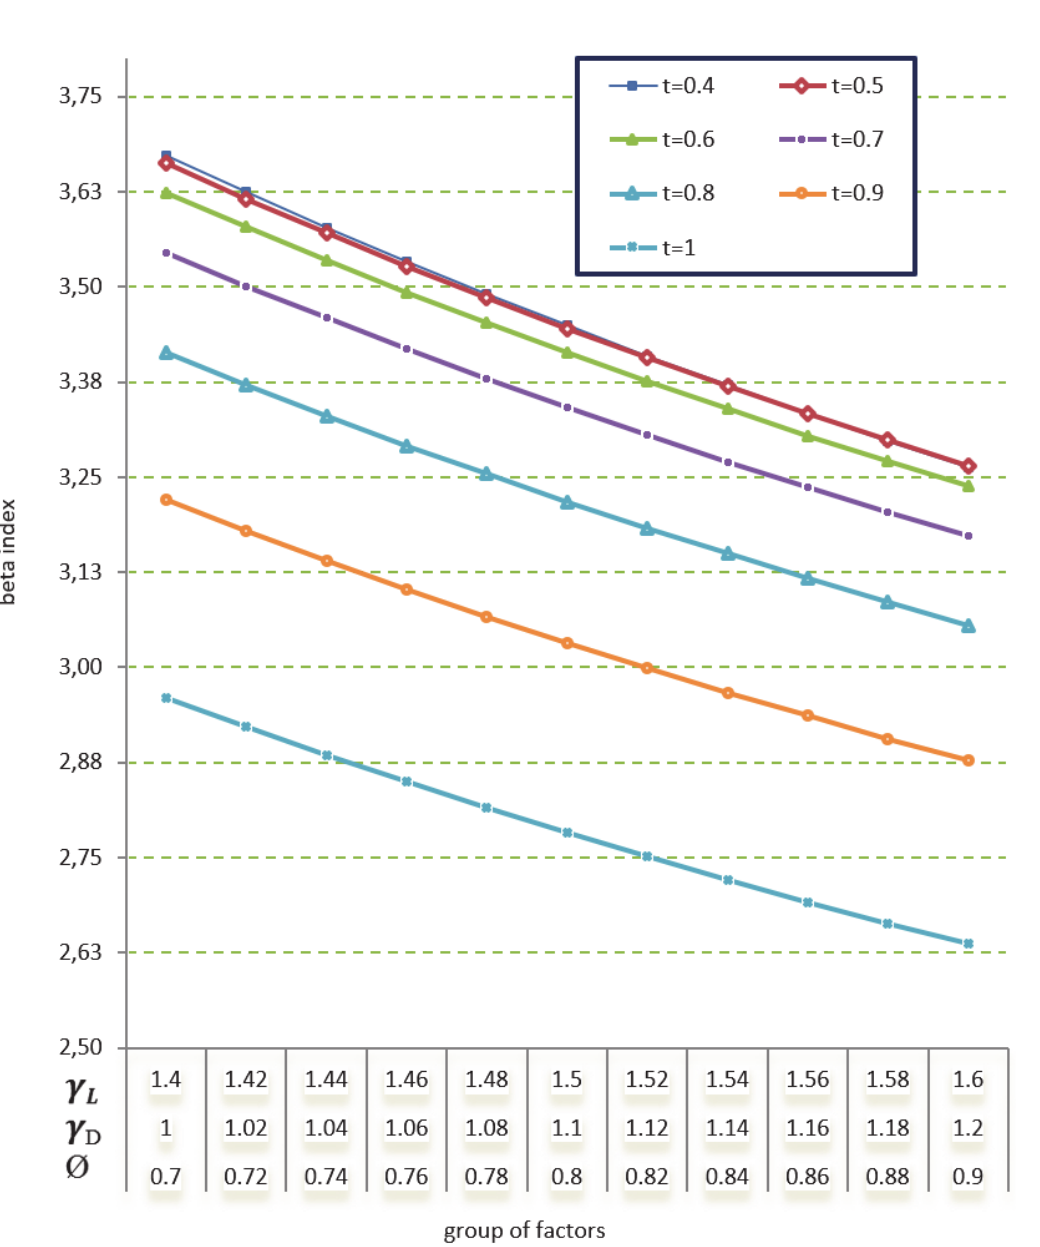
Figure 10: Prediction load and resistance factors for T section beam in combined